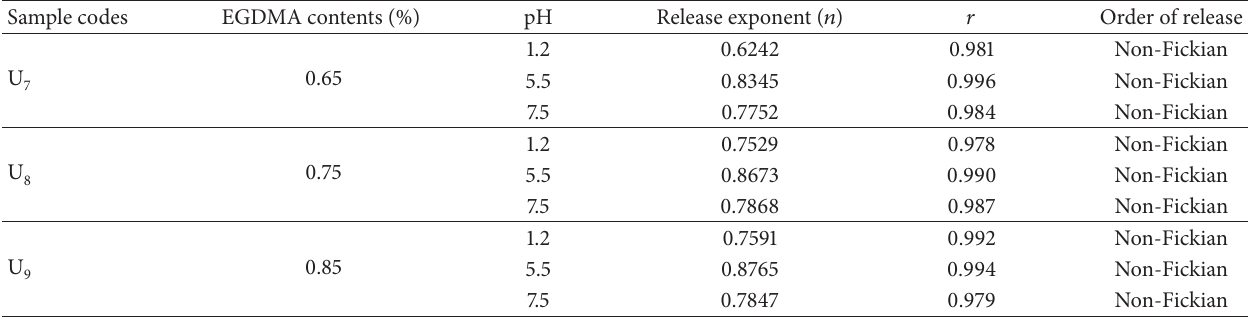
Table 9: Effect of degree of cross-linking on drug release mechanism of AA/Gelatin hydrogels in solutions of different pH values. Sample